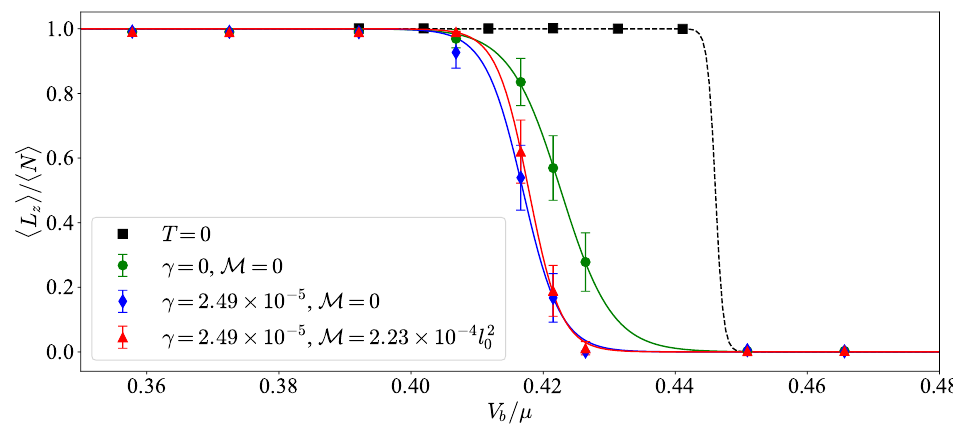
Figure 18: Final value of the average angular momentum per particle (which is equiv- alent to the final winding number) for the temperature T = 195nK and a barrier hold = 2.5s. There are several datasets corresponding to T = 0 GPE simu- time of t hold lations (black squares), and various subtheories of the SPGPE. Note that M is given = (cid:112) ħ h / m ω ≈ 1.3 µ m is the radial lengthscale set by the trap. in units of l 2 , where l r 0 0 〉 / 〈 N 〉 = [ exp (( V /µ − α ) /β )+ 1 ] − 1 , Each data set is fitted to a sigmoidal function: 〈 L z b where α , β are the fitting parameters. Error bars give a 95% confidence interval in the data. Notably, the absence of energy damping ( γ (cid:54) = 0, M = 0) does not deviate significantly from the full SPGPE result ( γ (cid:54) = 0, M (cid:54) =